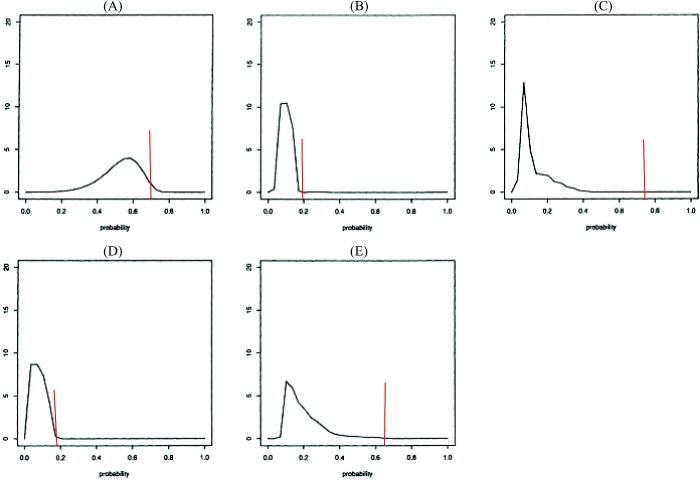
Elicited priors for the five elicitees. The red vertical line at P0 is the “best guess” two-year incidence of TOXO or death under placebo. The smoothed densities are for two-year TOXO or death incidence under pyrimethamine, conditional on the placebo rate.